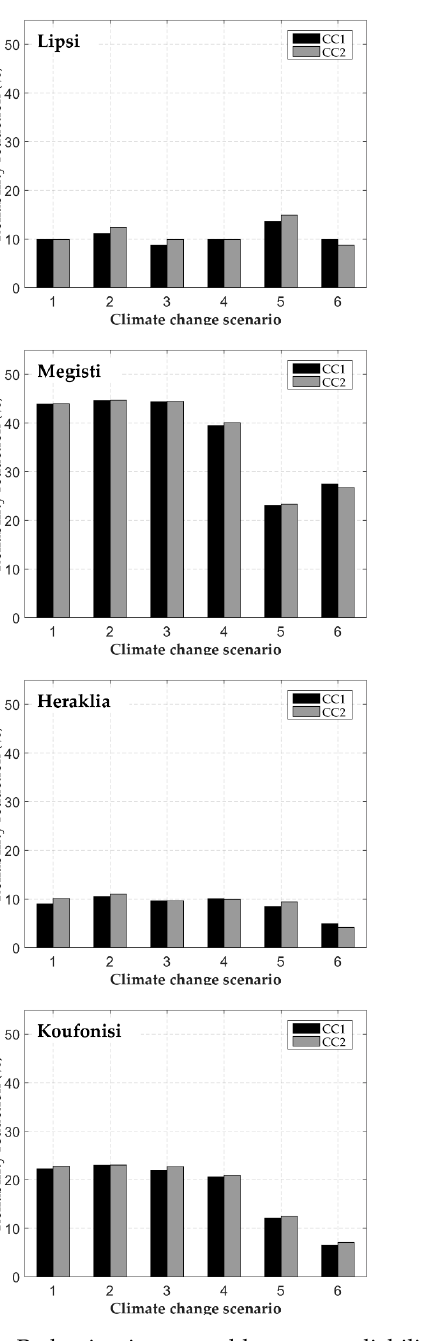
Figure 6. Reduction in renewable energy reliability under climate change (CC) for the best water resources management (WRM) scenario per island.